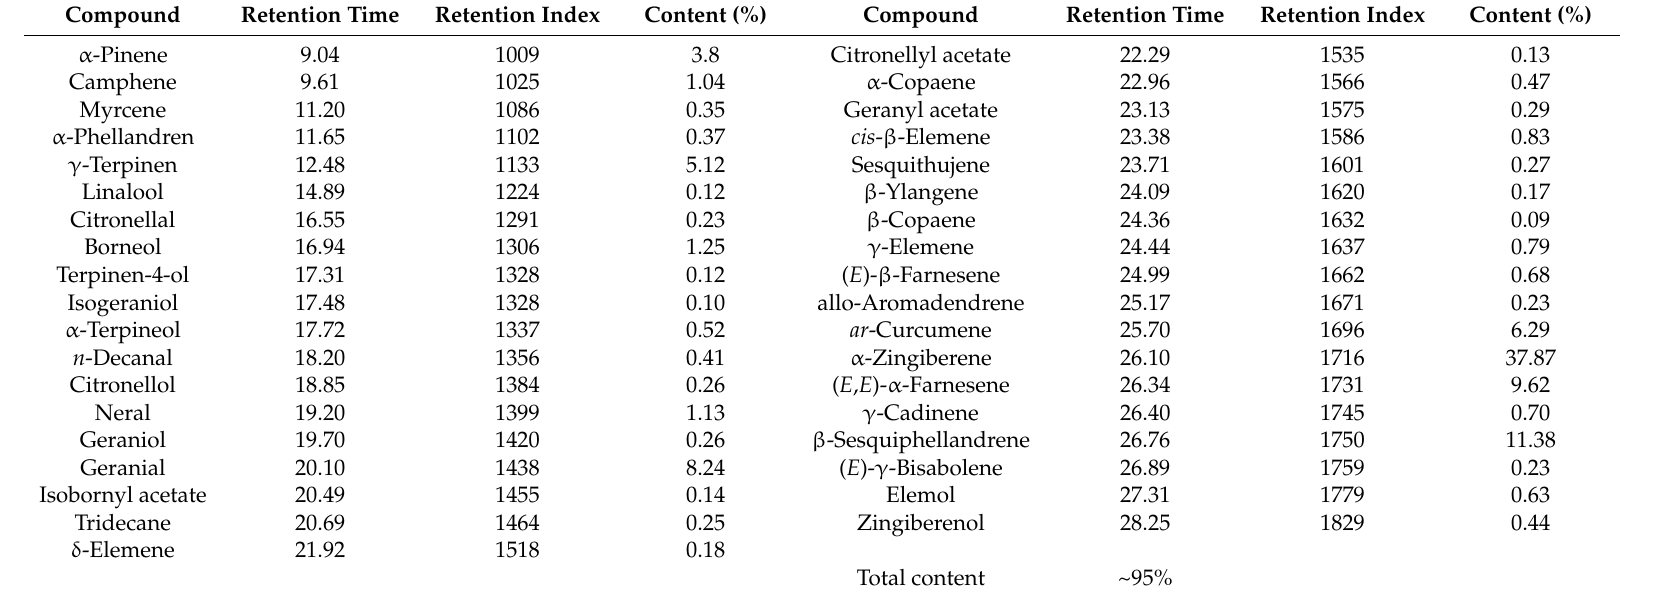
Table 1. Volatile components identified in the extracts from fresh ginger